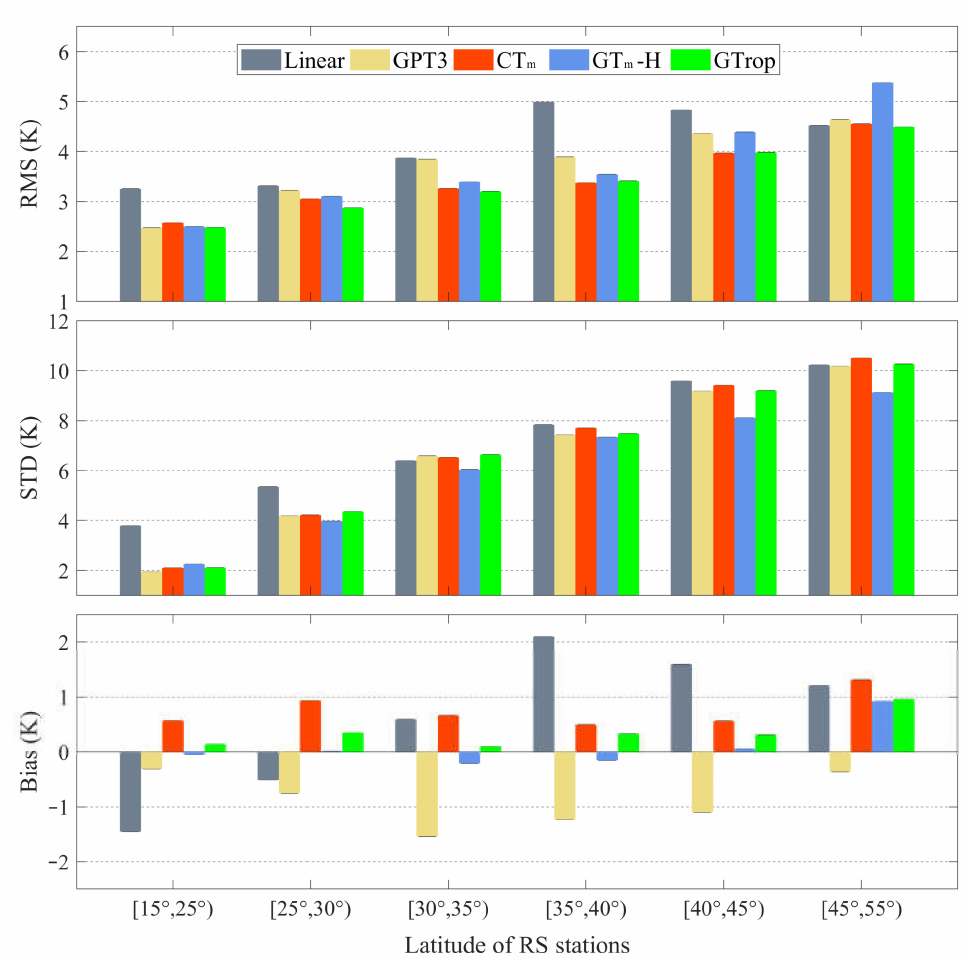
Figure 5. Average RMS and Bias of the five T m models at different latitudes over the period of 2011 to